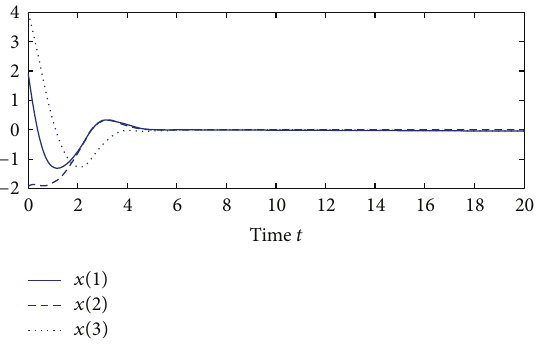
Figure 2: State response of system